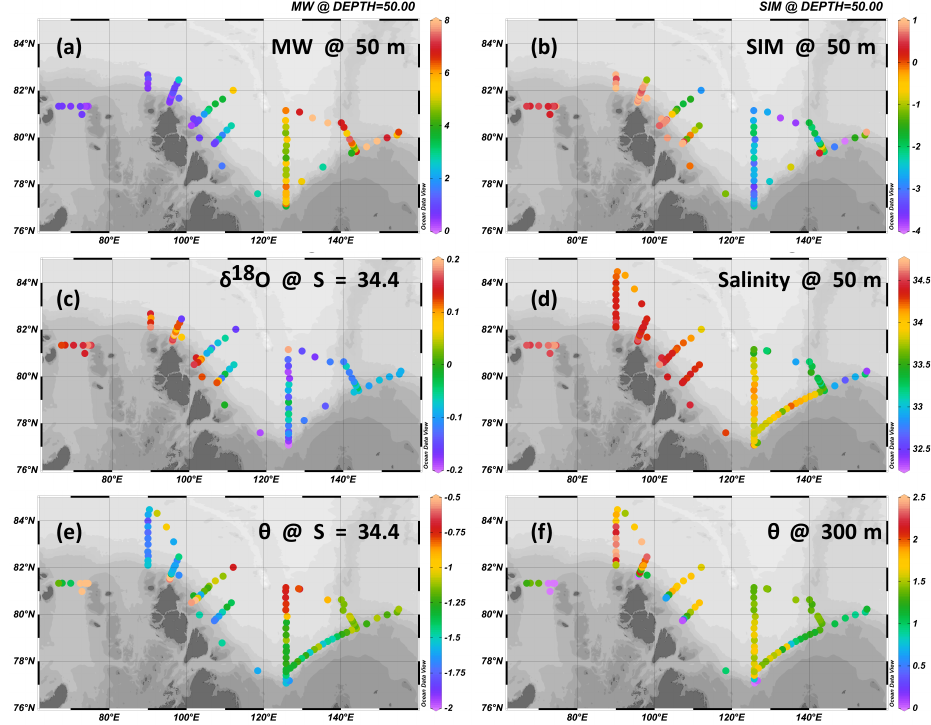
Figure 4. Maps of the (a) meteoric water (MW) fraction (%) at 50m depth, (b) net sea-ice meltwater (SIM) fraction (%) at 50m depth, (c) δ 18 O (‰) on the 34.4 isohaline, (d) salinity at 50m depth, (e) potential temperature ( ◦ C) on the 34.4 isohaline, and (f) potential temper- ature ( ◦ C) at 300m (i.e., the approximate depth of the AW core). The MW and SIM fractions were calculated using a coupled water-type analysis conserving salinity, δ 18 O, and mass according to methods outlined in Alkire et al. (2015); specific details regarding the methods of the analyses are provided in the Supplement text S2. Maps were created using Ocean Data View software (version 4.7.6; Schlitzer, 2016).